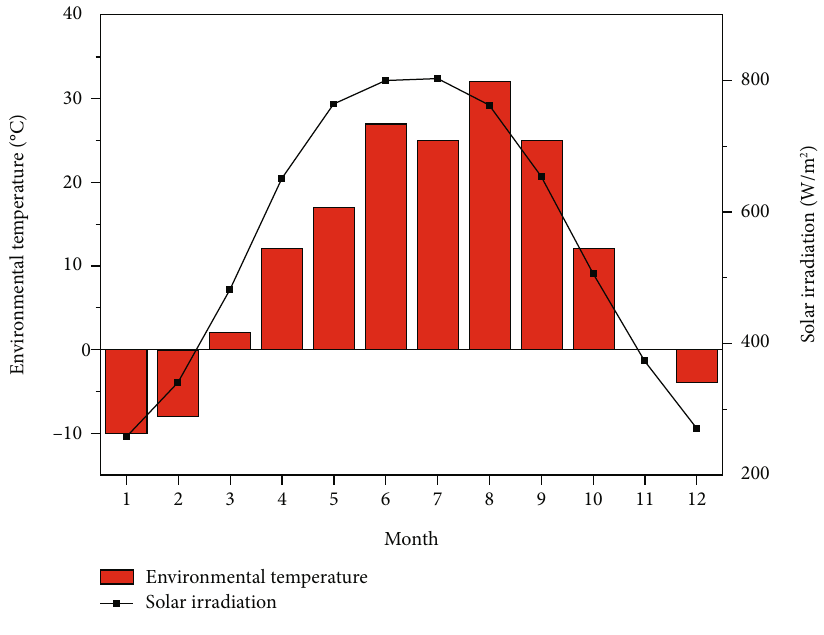
Figure 6: Simulated meteorological data. Table 1: Physical parameters of materials.